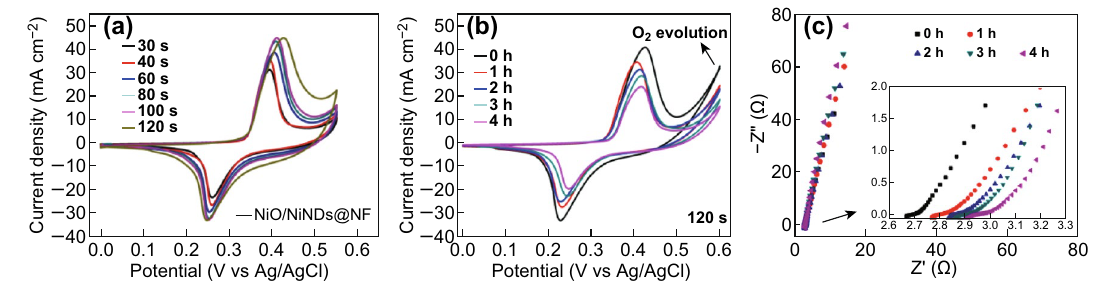
Fig. 2 CV characteristics (scan rate of 5 mV s −1 ) of a NiO/NiNDs@NF electrodes with different deposition time and b 120‑s deposited NiO/ NiNDs@NF electrodes before and after heating at 200 °C. c Corresponding Nyquist plots of the curves shown in panel b over the frequency range of 0.01 Hz–100 kHz with 5 mV AC amplitude at an overpotential of 0 V in 1.0 M KOH. Inset is a local enlargement of the high‑frequency